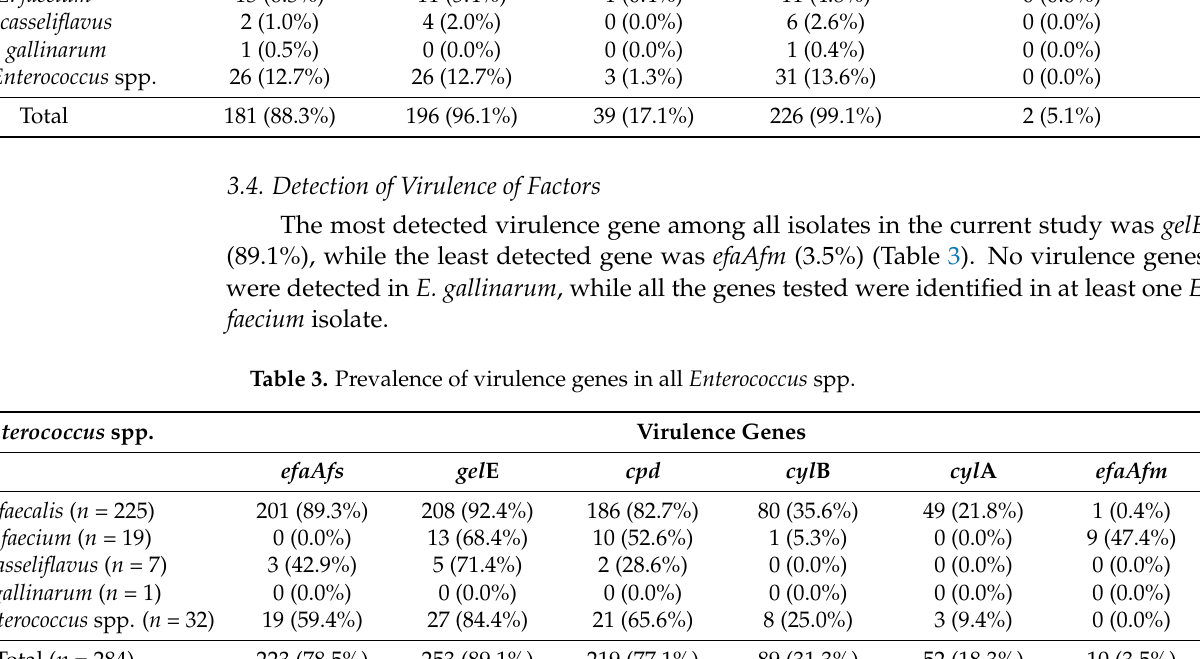
Enterococcus spp.